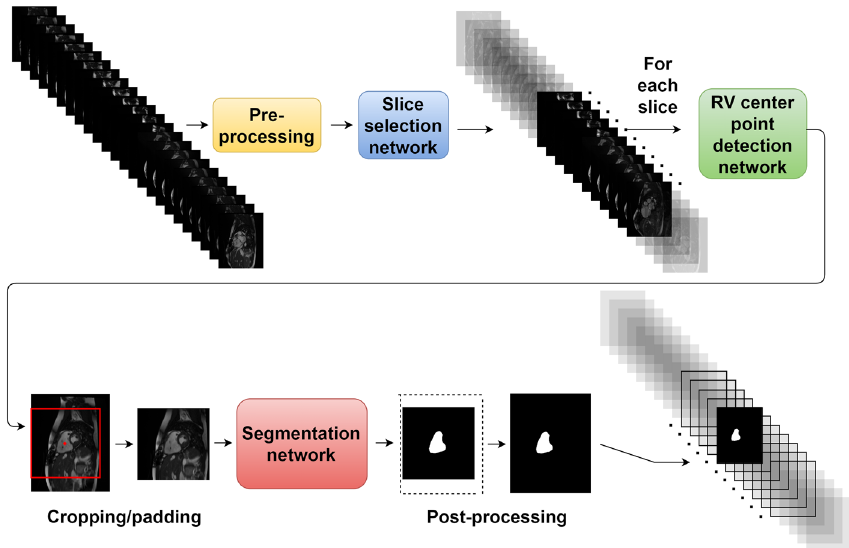
Figure 2. A flowchart of the pipeline. An input timeframe is pre-processed and inserted into a slice selection network that selects slices containing RV cross-sections. The RV center point is then detected in each selected slice by the RV center point detection network and used to crop (or pad) each slice around the RV before insertion into the segmentation network. This yields a segmentation of the RV, that is then inversely padded or cropped to match the original slice